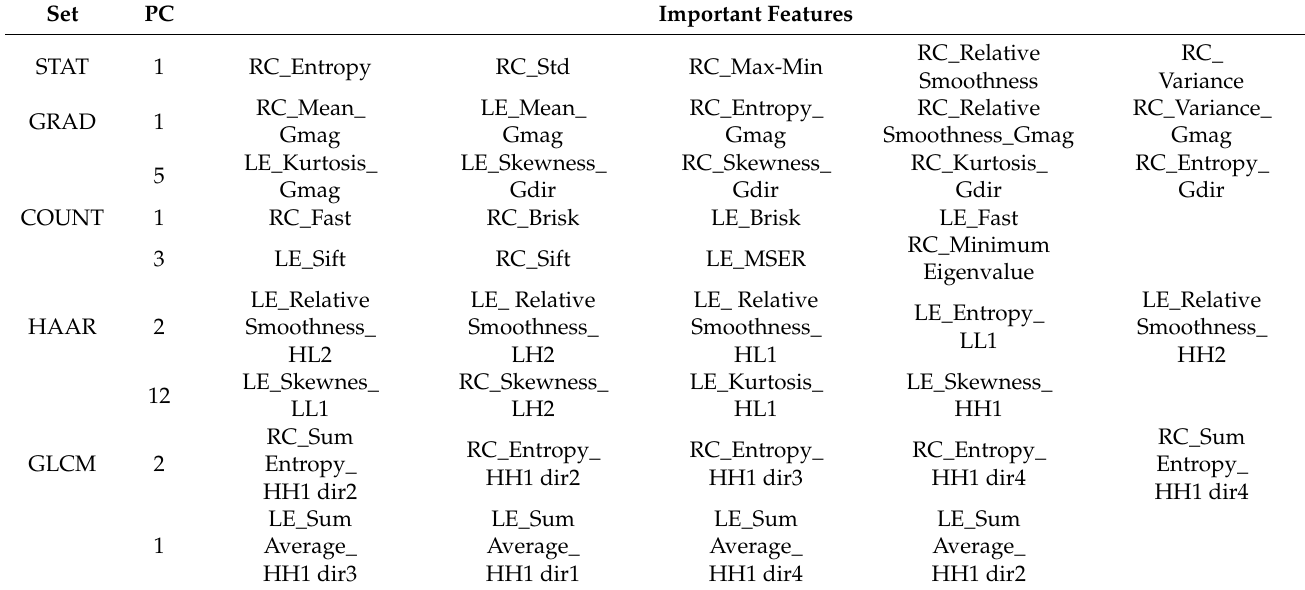
Table 2. Overview of the features that were important in the computation of the selected PCs on 100 ten-fold cross-validation rounds. The factors, LE and RC identify the features extracted from the LE images and the RC images, respectively.